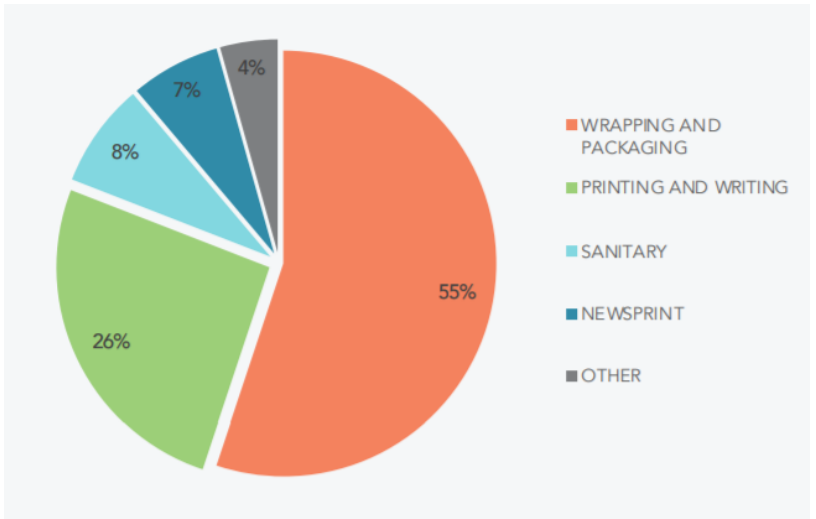
Figure A9. Global consumption by paper category, in tons. Source: https://environmentalpaper.org/wp-content/uploads/2018/04/StateOfTheGlobalPaperIndustry2018_FullReport-Final-1.pdf (accessed on 8 June 2021).